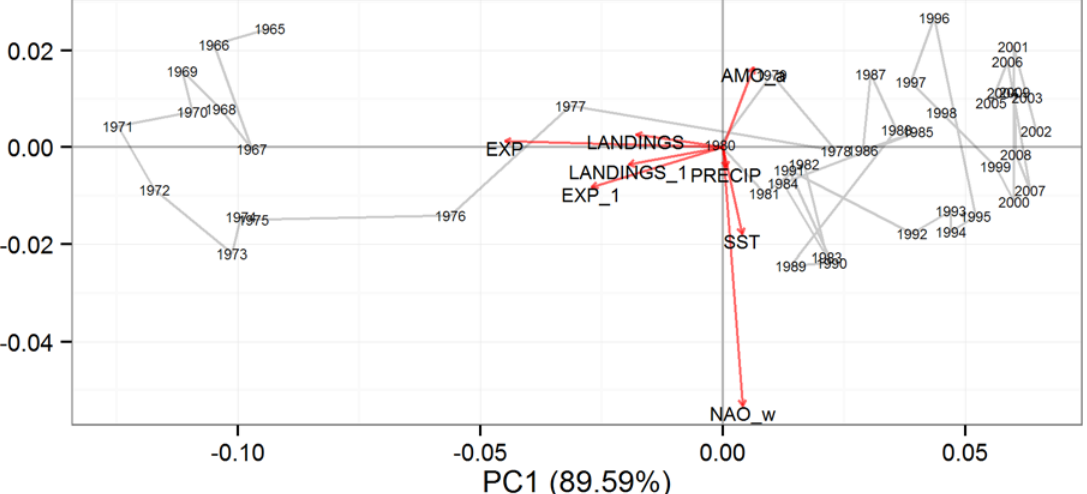
Fig 5. Biplot of the first two principal components display the coordinate positions and connecting segments for each year and indicating inferred compositional patterns. Environmental and anthropogenic pressure variables used in the analysis displayed as